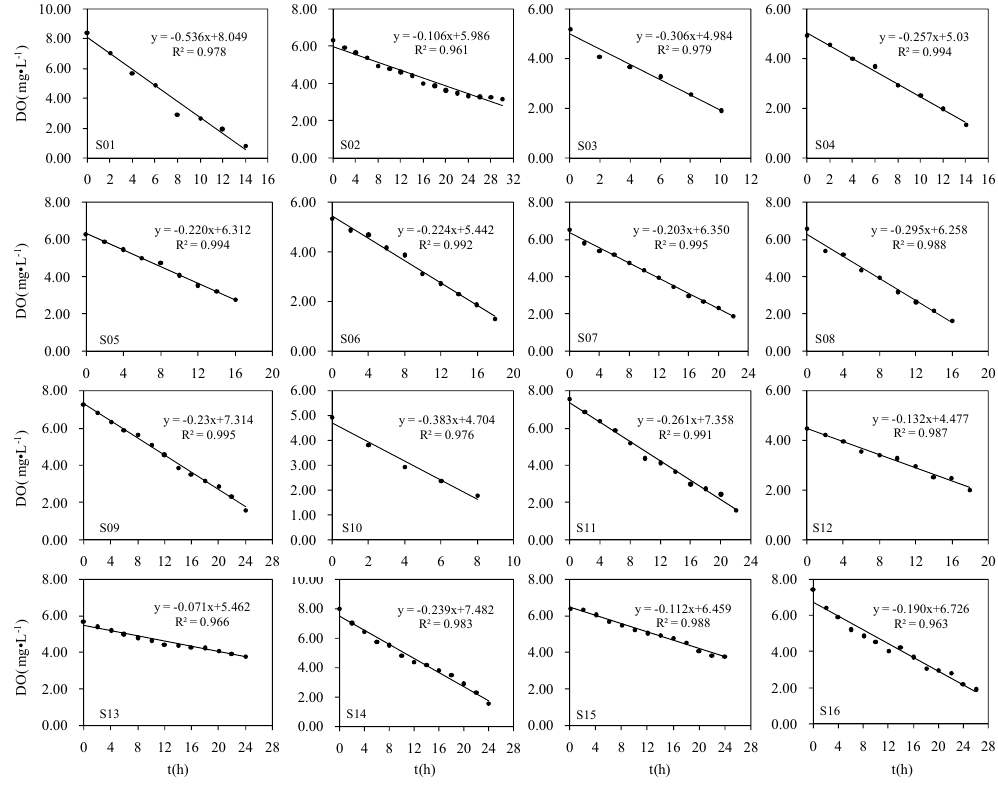
Figure 2. The DO depletion profiles in water overlying the sediment measured by laboratory core incubations during August, 2003 at 16 sampling stations in the Ziya River Watershed. Spatial variations of the SOD determined by laboratory core incubations are presented in Figure 3. SOD rates measured in the laboratory corrected to 20 °C ranged from 0.19 to 1.41 g/(m 2 ·d), with an average of 0.62 g/(m 2 ·d). Maximum SOD was found at S01 and minimum SOD was found at S13, with a factor of 7.5 between the extremes. Spatial variation of SOD in the Ziya River watershed was very apparent. High levels of SOD were presented in the upstream and the midstream parts of the watershed, and the SOD in the downstream was relatively low. The average flux in the upstream was 0.72 g/(m 2 ·d), which was the same as the average flux in the midstream but higher than that in the downstream (0.39 g/(m 2 ·d)). Many capillary tributaries in the upstream and the midstream parts of the watershed widely admitting domestic and industrial wastewater may be the causes of the higher SOD in these areas.